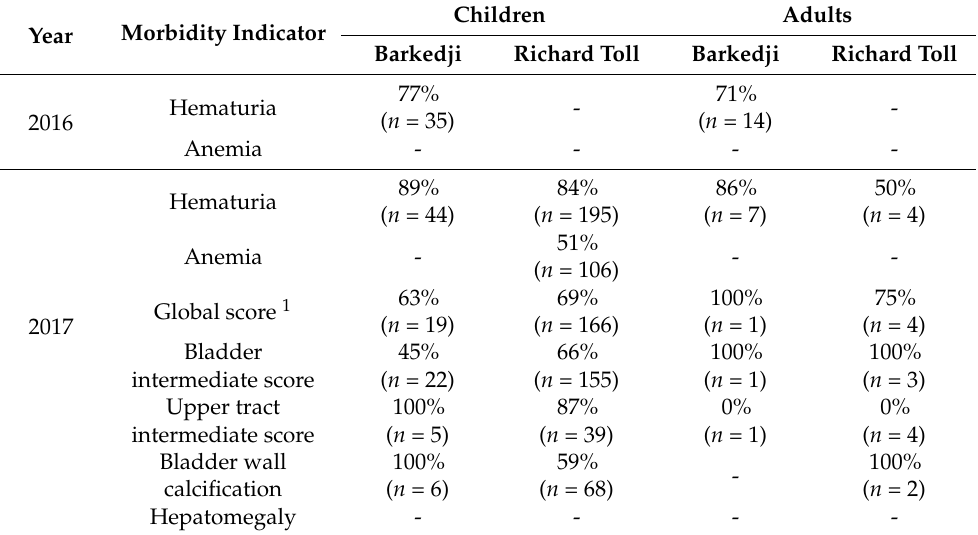
Table 5. Proportion of children and adults whose morbidity levels decreased one month after treatment with praziquantel in two study sites in Senegal in 2016 and 2017 (number of individuals examined indicated in parentheses; only individuals with anemia, hematuria, or lesions observed using ultrasound pre-treatment were included).